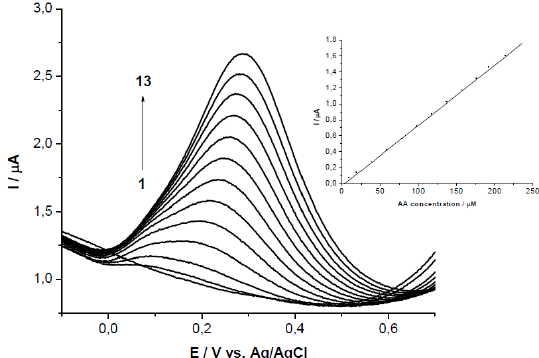
Figure 12. SWVs for AA solution with different concentrations: (1) 0 μM; (2) 9.99 μM; (3) 19.96 μM; (4) 39.84 μM; (5) 59.64 μM; (6) 79.36 μM; (7) 99 μM; (8) 118.5 μM; (9) 138.06 μM; (10) 157.48 μM; (11) 176.81 μM; (12) 193.07 μM; (13) 215.26 μM; in the presence of propylene glycol (Inset: calibration